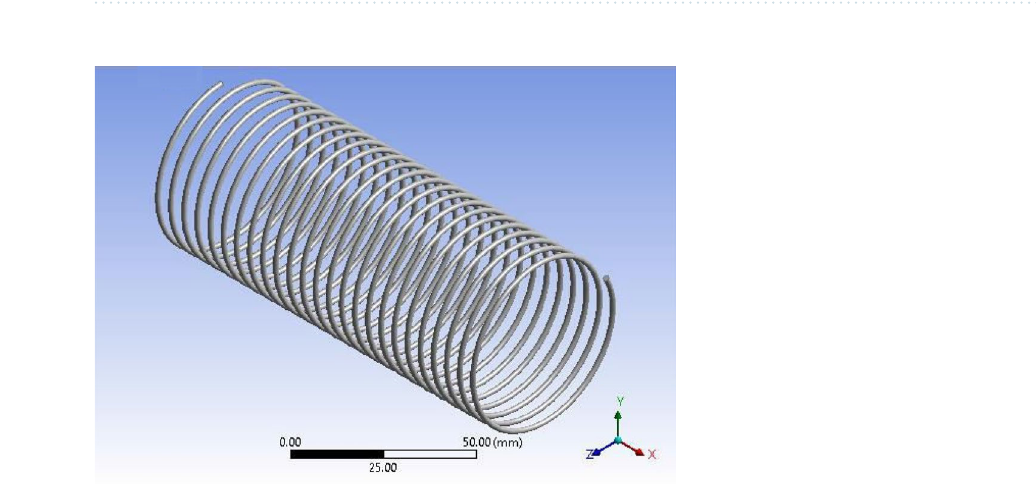
Figure 3. ANSYS FLUENT model of Tube-2 (3657.6 mm).